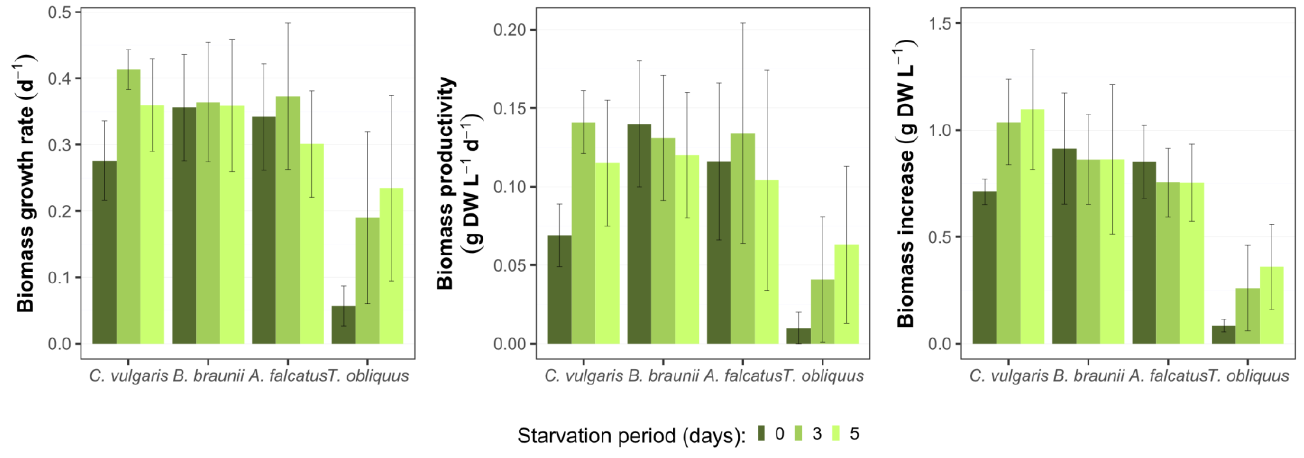
Figure 2. Biomass growth parameters for C. vulgaris, B. braunii, A. falcatus, and T. obliquus in batch conditions after various P-starvation periods within ten days (means ± SD, n = 3).